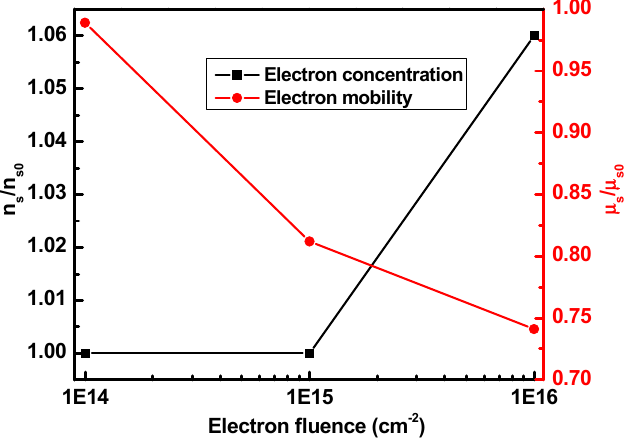
Figure 6. The variation of electron concentration and mobility with the electron fluence.